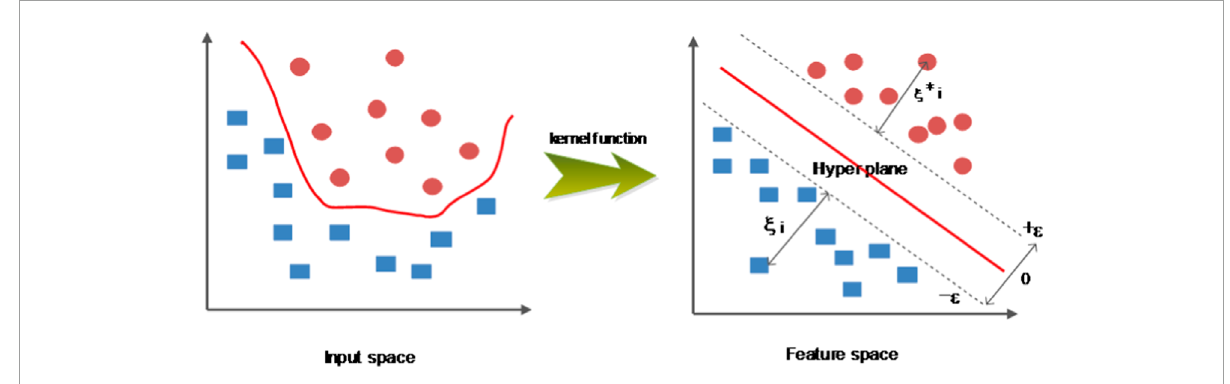
FIGURE 2 Transformation process illustration of the